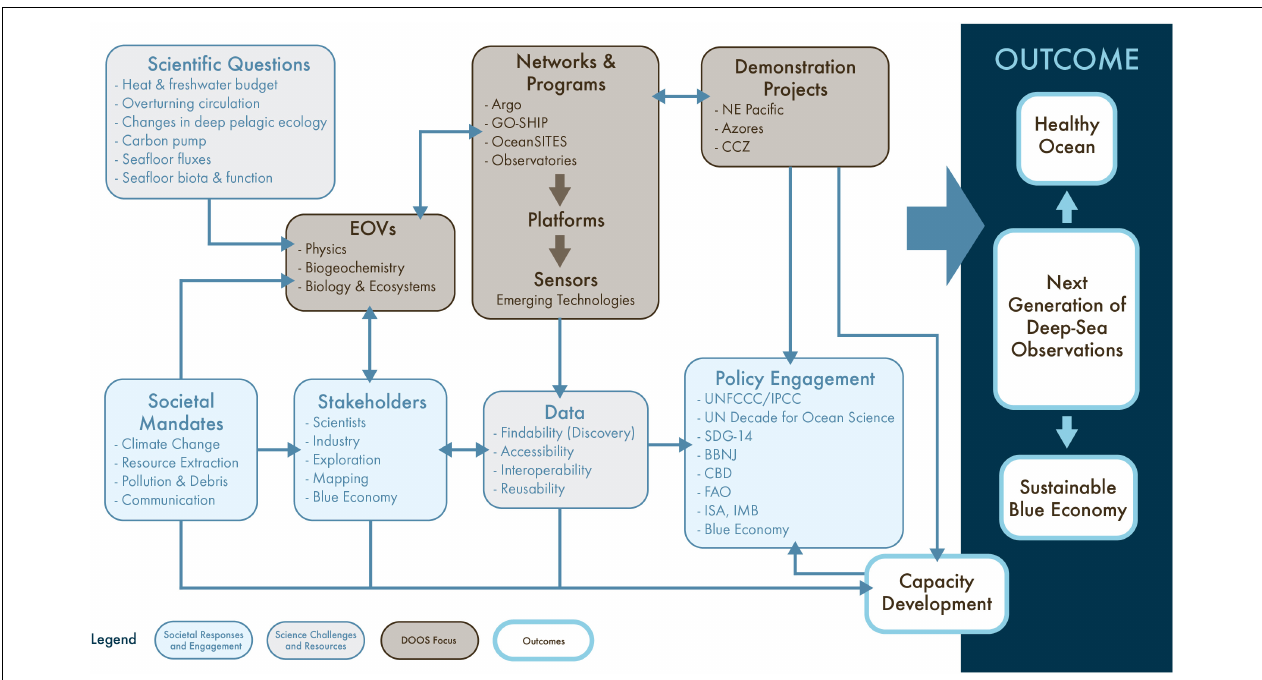
FIGURE 5 | The key components of a deep-ocean observing strategy designed to promote healthy oceans and a sustainable blue economy.